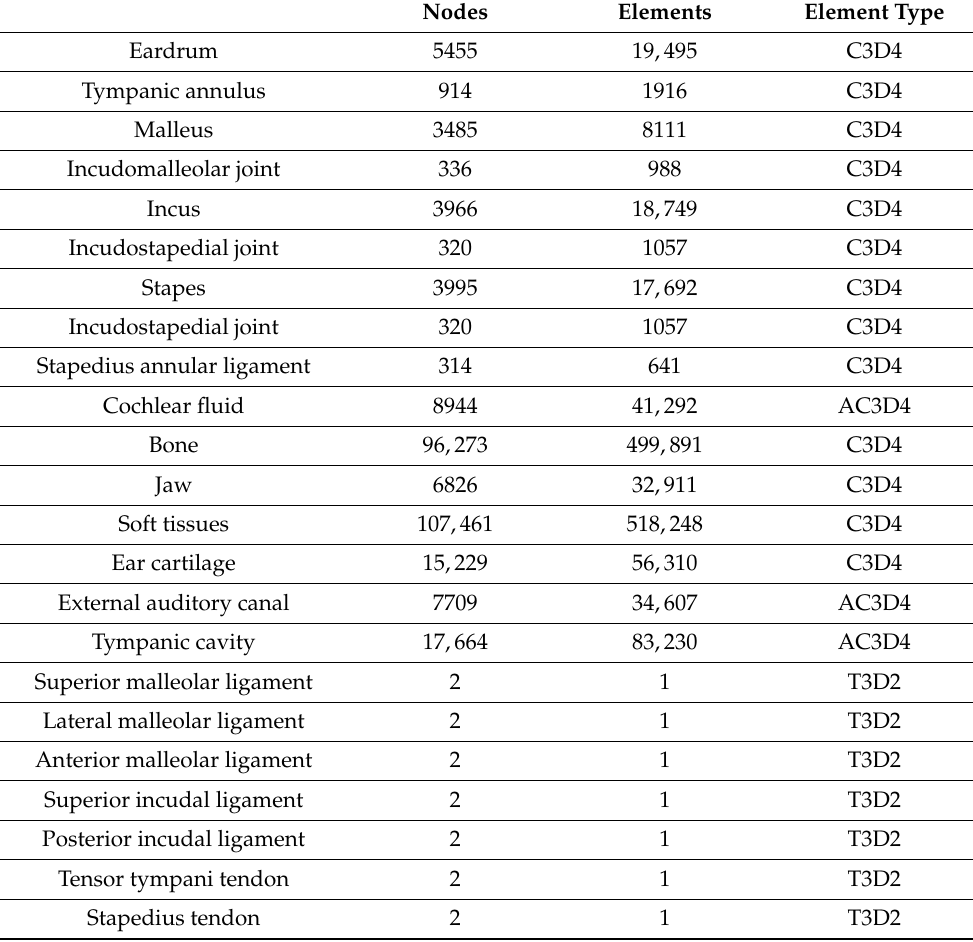
Table 4. Number of nodes and elements and their respective element